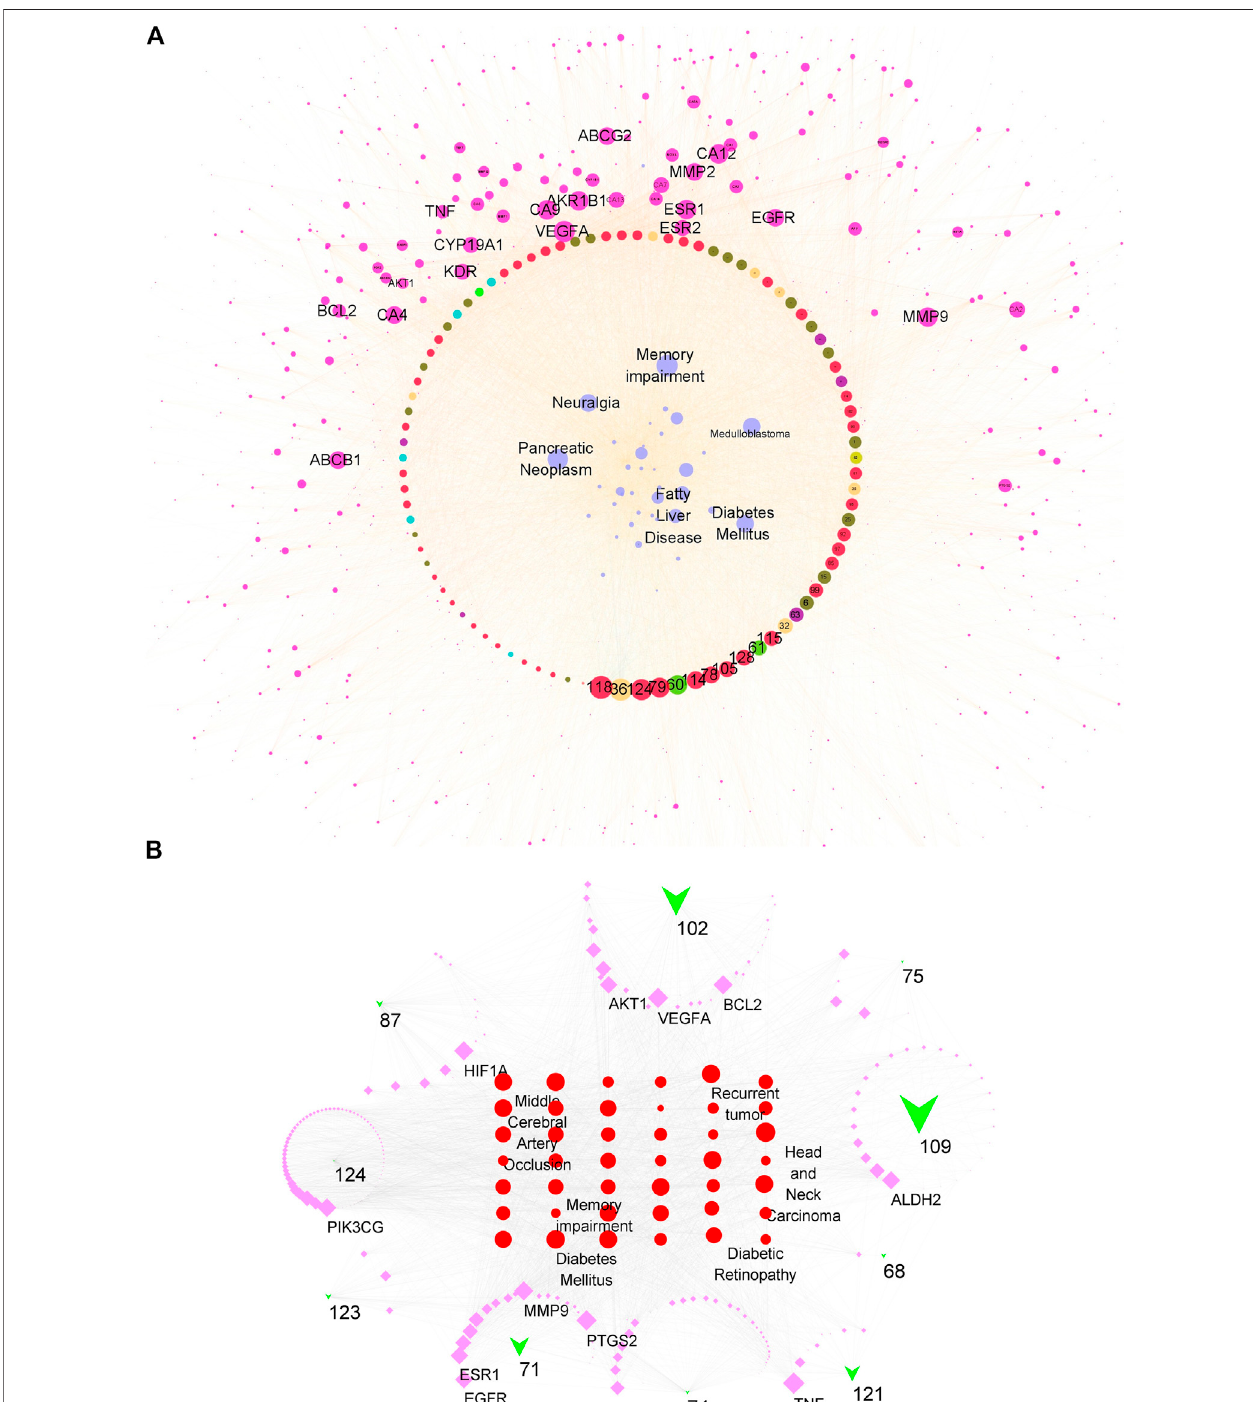
FIGURE 4 | Compound – target – disease network for all candidate or main compounds of the extract of CT. (A) Network for all candidate compounds. The red/ wathet blue/green yellow/grass green/green/blue/green/nacarat/orange/sepia node respectively represented the fl avone/anthraquinone/anthraquinone/alkaloid/ steroid/erpenoid/polyacetylene/phenol/phenylpropanoid compounds, thepurple node represented thecompound targets, wathet node represented thediseases,and edge represented the interaction between each other. (B) Network for 10 main compounds. The green trilateral node represented compounds, the purple square represented targets, and the red circle represented diseases.